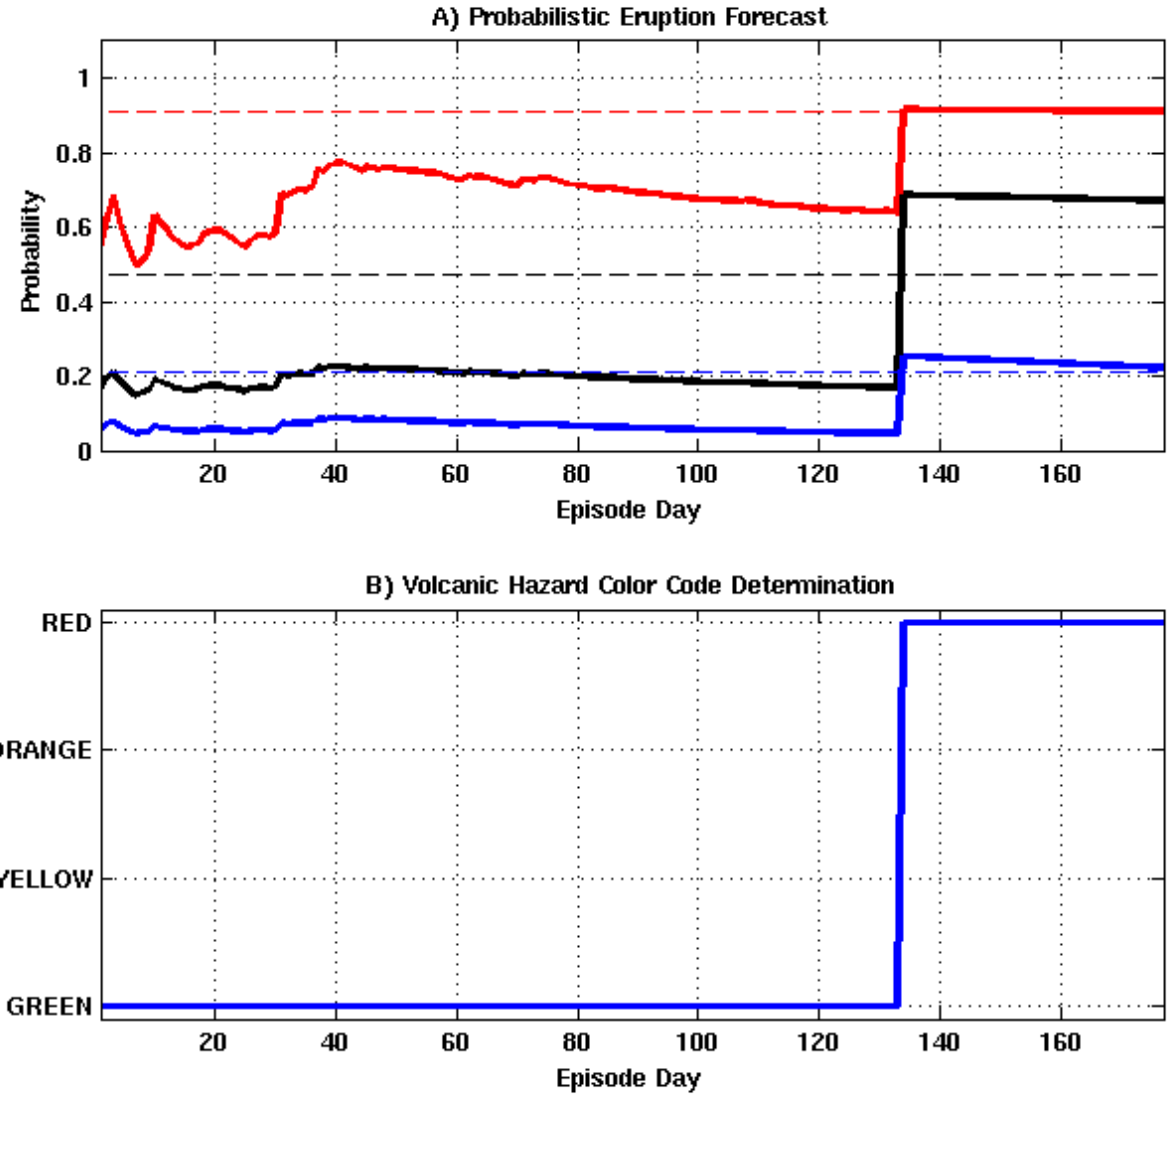
Figure 15. Forecasts of volcanic activity preceding Grimsv¨otn 2011 eruption, where the intrusion, eruption, and intensity probabilities and thresholds are shown by the red, black, and blue, solid and dotted lines. Introduction of positive modeling results occurs on episode day 134. ( A ) Probability of occurrence for event tree nodes; ( B ) Volcanic hazard color code